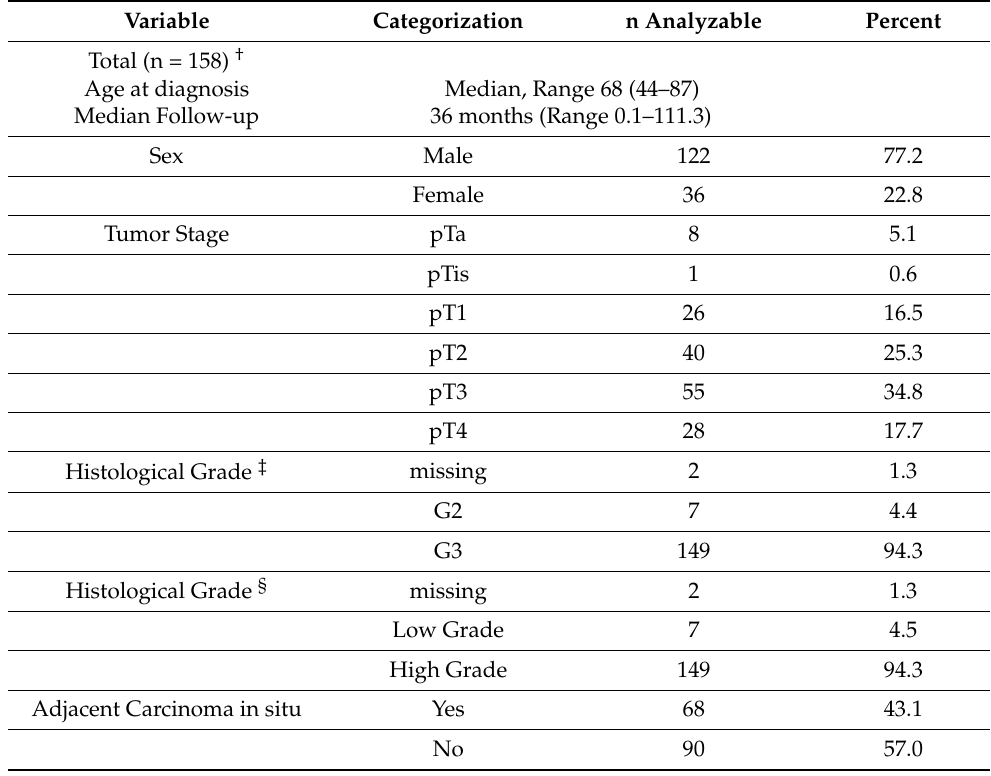
Table 1. Patient and tumor